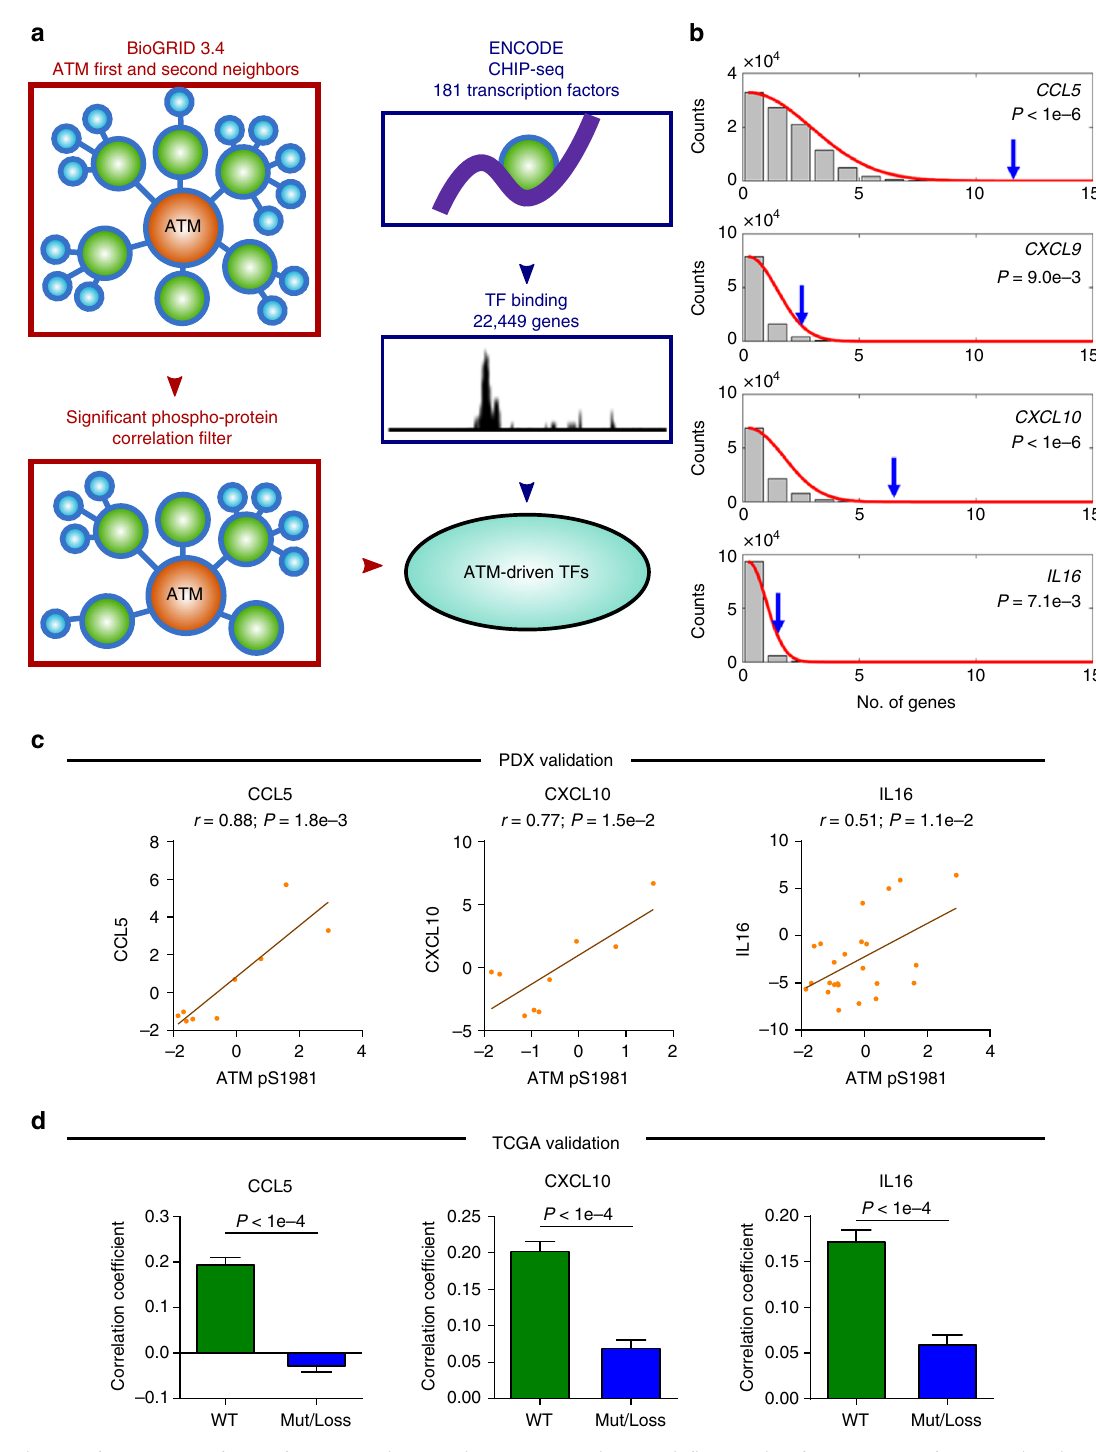
Fig. 5 Enrichment of transcription factors for CTL cytokines in the ATM network. a Work fl ow to identify transcription factors within the ATM second neighbor network. b Enrichment of transcription factors that drive cytokines implicated in CTL recruitment. Blue arrows indicate number of transcription factors in ATM second neighbor network. The null distribution shown in the background represents number of transcription factors bound in randomly selected gene sets of equal size, which was used to determine an empirical P -value (inset). c Correlation of ATM phosphorylated at S1981 and cytokine protein levels in PDX breast cancer models ( N = 27). Spearman correlation coef fi cient (r) and corresponding P -value indicated above plot. Error bars represent mean ± SEM. d Analysis of breast cancer patients with genomic alteration of ATM shows loss of correlation between ATM and cytokine expression compared to patients with wild type (WT) ATM. Correlation coef fi cient distributions were determined by random subsampling of each population to ensure equal sample size. Error bar represents 95% con fi dence interval, P -values determined by Wilcoxon rank-sum test. Error